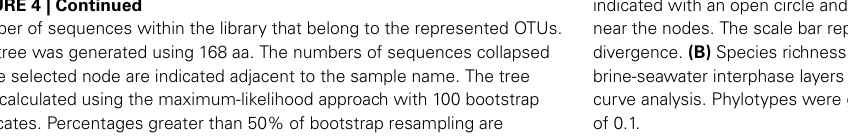
indicated with an open circle and those greater than 70% with a closed circle near the nodes. The scale bar represents 10% estimated sequence